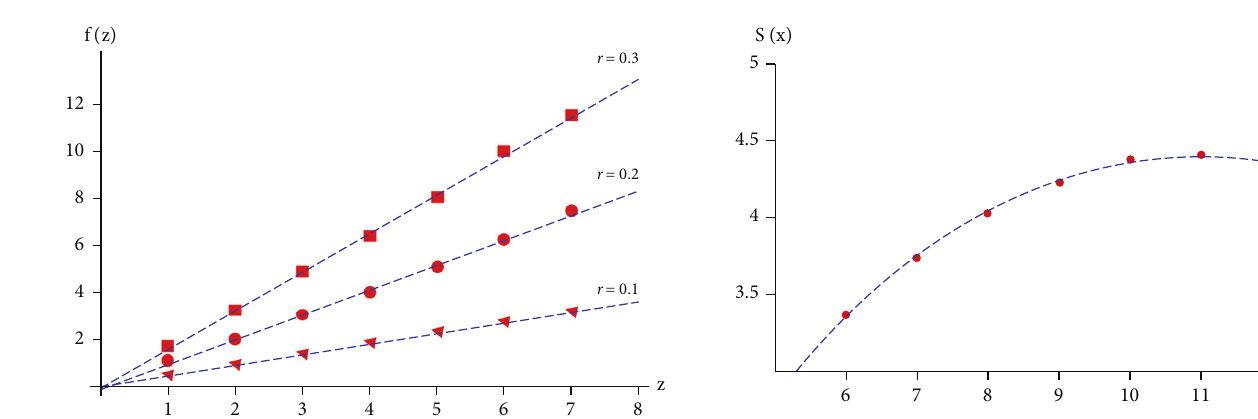
Figure 2: Numerical results for the OTOC in a random circuit resembling AdS space. To minimize boundary e ff ect and parity asymmetry, we take the average of the data from i = 8 and i = 9 . For the cases of p = 0 : 9 and r = 0 : 1,0 : 2,0 : 3 , respectively, f ð t Þ is approximately a linear function of radial scale t in AdS space.